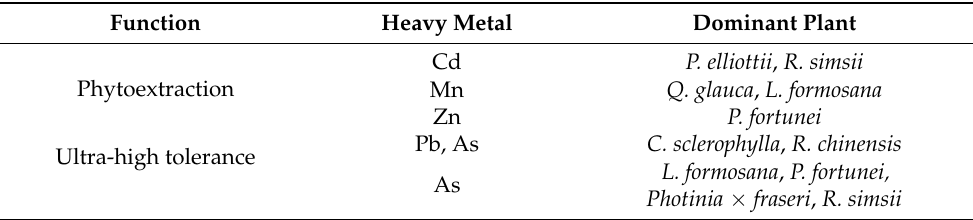
Table 3. Woody plants with potential for remediation of heavy metal pollution in study areas.